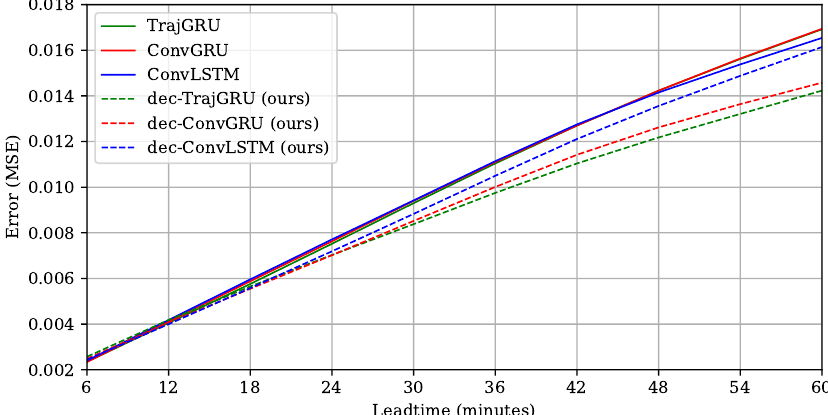
Figure 6. Comparison of our models with the models following Shi et al. [6] in terms of lead-time error (MSE) on the test set. Best view in